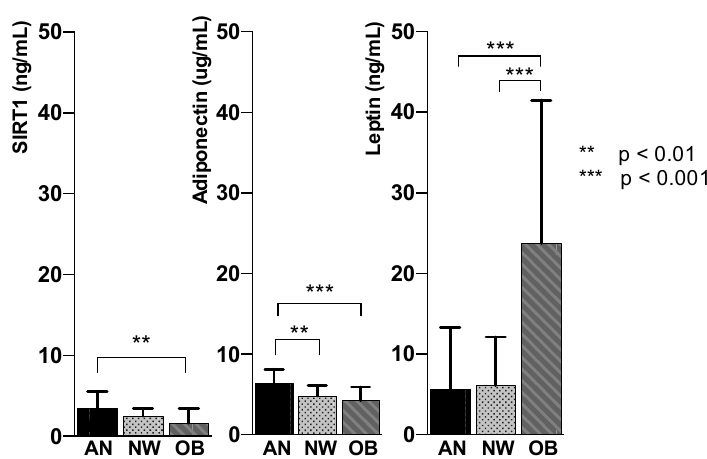
Figure 2. Representation of circulating SIRT1, adiponectin and leptin mean values in anorexia nervosa (AN, black column), normal weight (NW, gray column with dots) and obesity (OB, gray column with stripes).